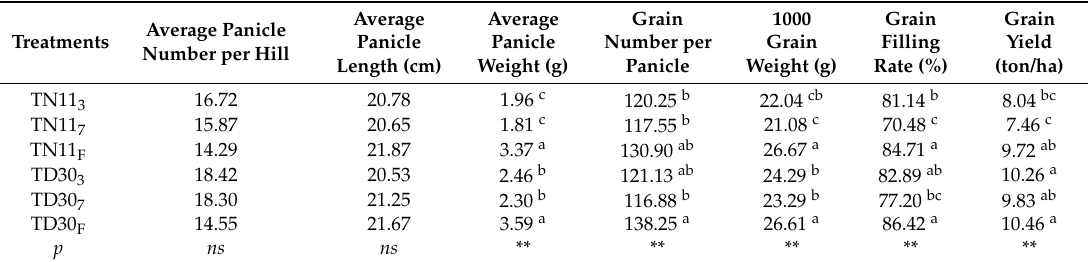
Table 4. Effects on irrigation regimes on yield and yield components.